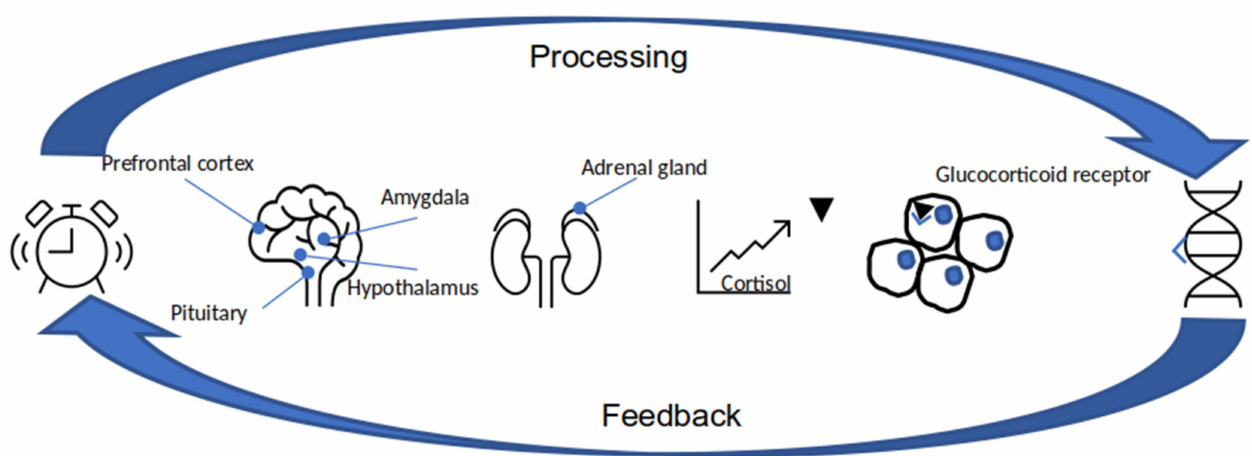
Figure 2. Pathway showing stress and DNA